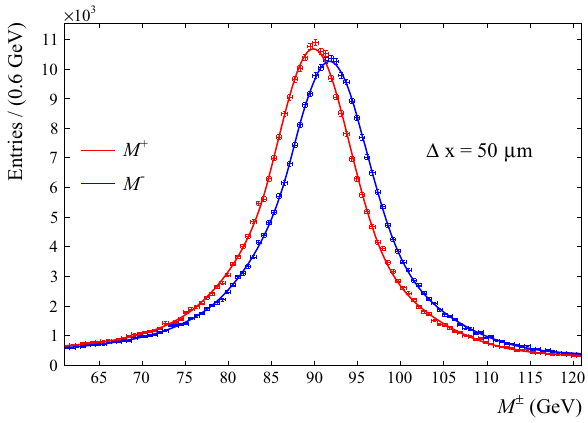
Fig. 2 Theparametricfitofthe M + and M − pseudomassdistributions, in the presence of a Δ x = 50 μ m. The signal is modelled with a double Crystal Ball function, while the non-peaking component of the Z /γ